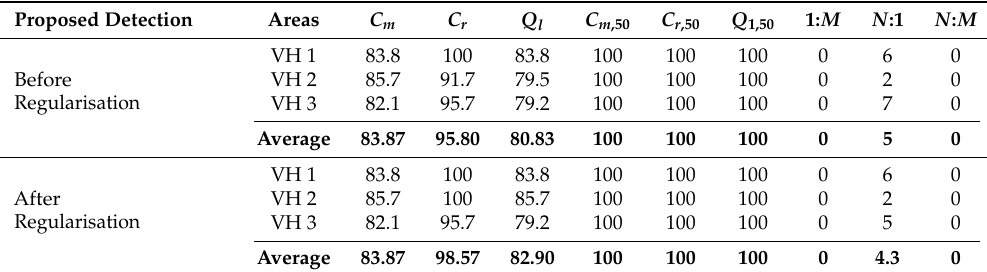
Table 2. Object-based building detection results on the Vaihingen (VH) data set before and after regularisation stage. ( C m = completeness, C r = correctness and Q l = quality, are for all the buildings and over 50 m 2 in percentage; 1:M = over-segmentation and N:1 = under-segmentation, N:M = both over- and under-segmentation in the number of buildings).